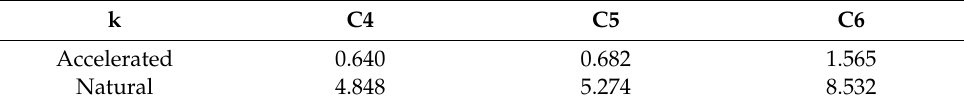
Table 17. k coefficients of C30/37 strength class concretes.